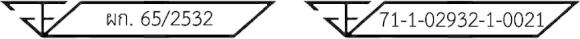
Thai FDA label before and after 2000.